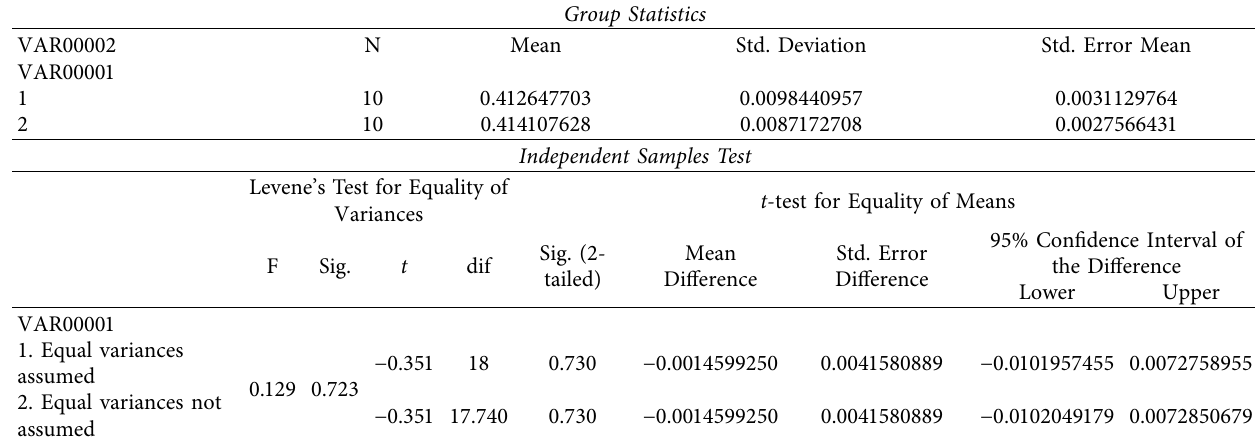
Table 8: The t -test on the Collins sample (MIPS reference clusters).